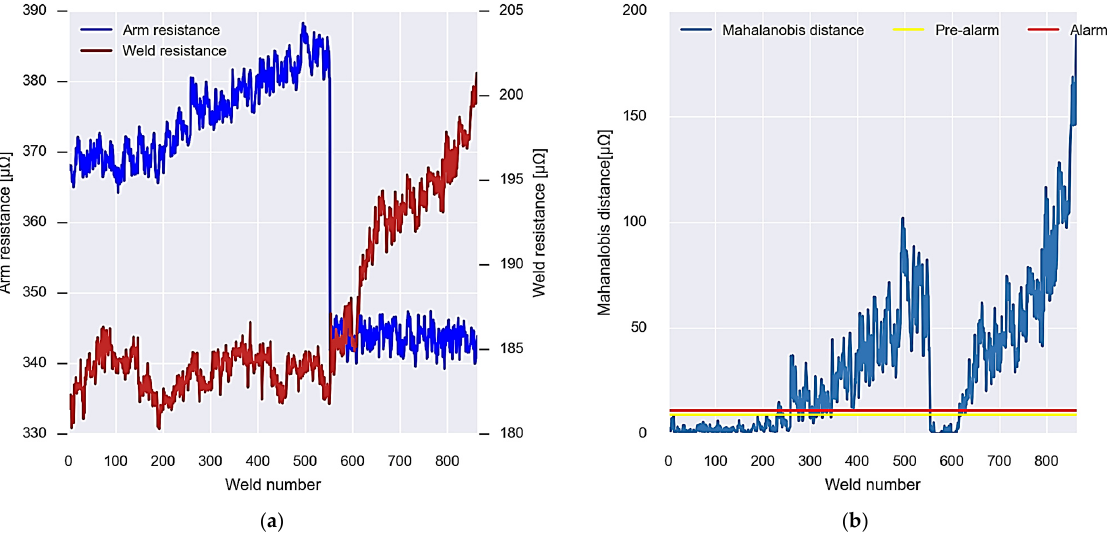
Figure 18. Gun 3 alarm system operation. ( a ) New incoming resistance data. ( b ) Analysis and recalibration of alarms.